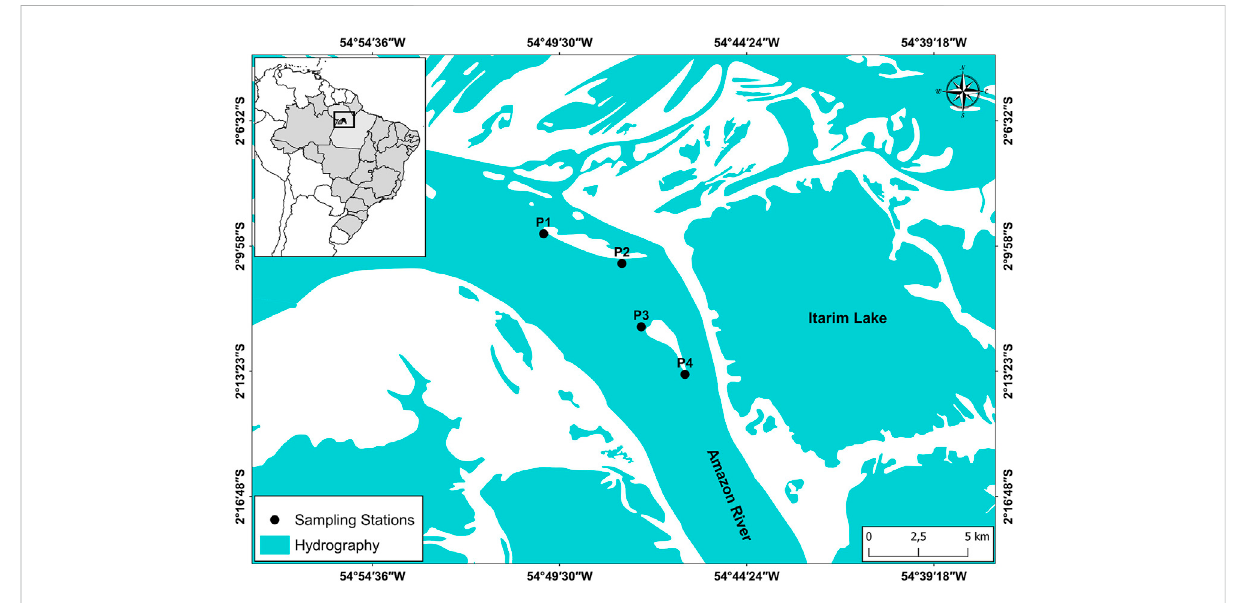
FIGURE 1 Study area, “ Ilha das Marrecas ” complex, lower stretch of the Amazon River, Pará,